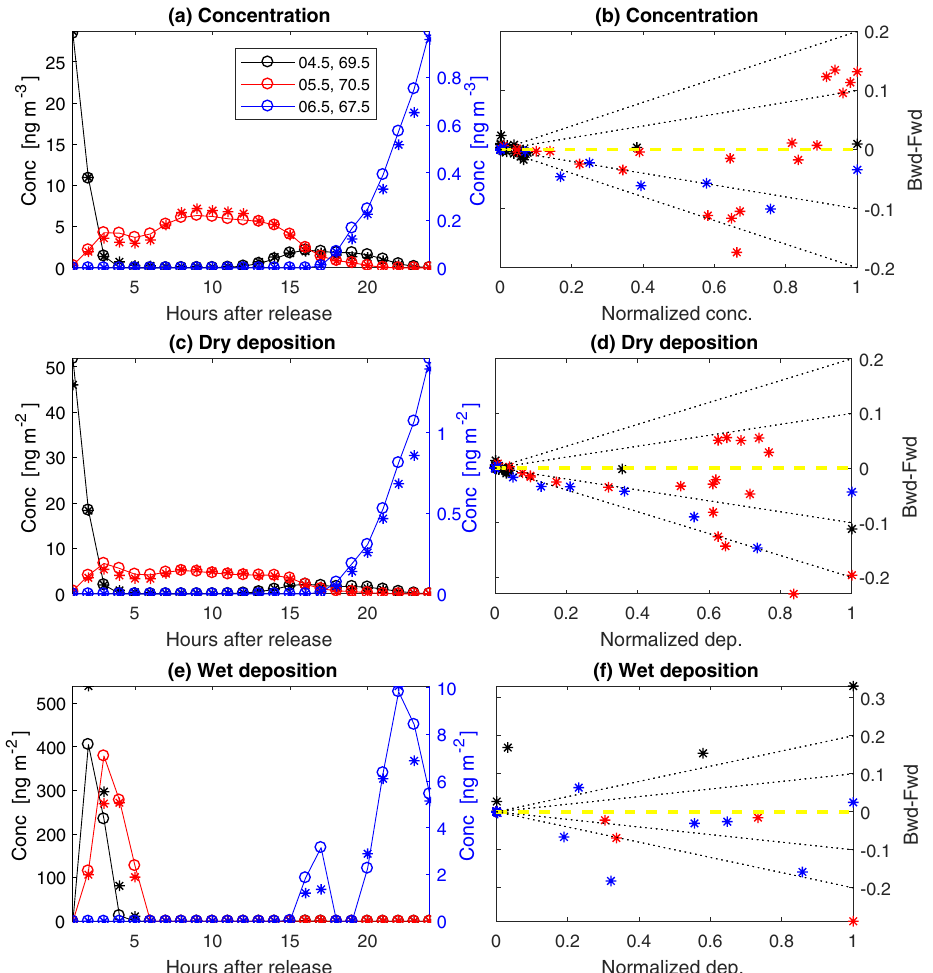
Figure 3. Comparison of modelled concentration and deposition values from forward and backward simulations for the three receptor grid boxes. (1) Black: 4.5 ◦ E, 69.5 ◦ N; (2) red: 5.5 ◦ E; 70.5 ◦ N; (3) blue: 6.5 ◦ E, 67.5 ◦ N. (a, c, e) The data as time series for the 24h after the emission. The stars depict the values obtained by the backward simulation and the circles and lines the corresponding values from the forward simulation. Notice that due to the lower simulated values at receptor grid box number three, the scales are different for this box and are reported on the right axis in blue colour. (b, d, f) The normalized difference between backward and forward (Bwd–Fwd) simulations as a function of the simulated value obtained with the forward simulation and normalized by the maximum simulated value in the forward simulation. Black dotted lines correspond to 10 and 20% relative error,